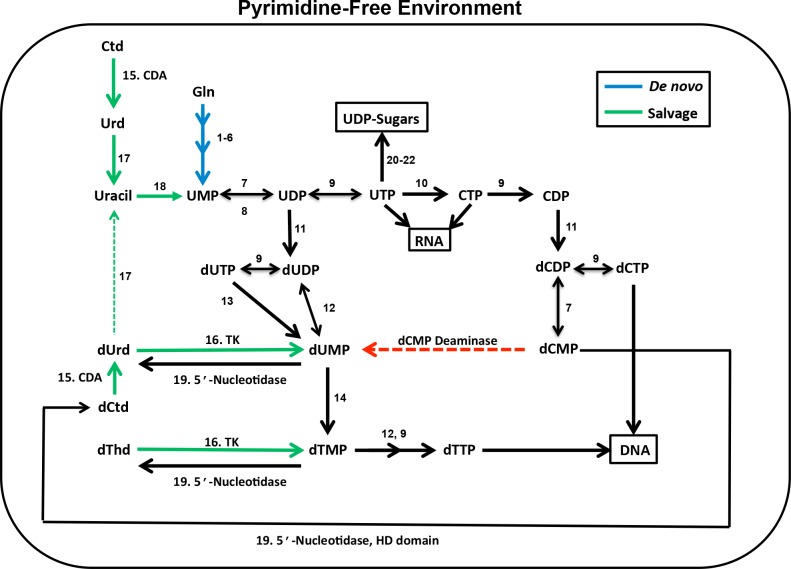

T. brucei pyrimidine pathway.Green lines salvage routes, blue lines de novo pathway, black lines interconversion routes, and the red dotted line indicates a reaction that is not present in trypanosomatids. The numbers above each arrow represent the enzyme catalyzing the reaction (EC number): 1–6: carbamoyl phosphate synthase (6.3.5.5), aspartate carbamoyl transferase (2.1.3.2), dihydroorotase (3.5.2.3), dihydroorotate dehydrogenase (1.3.98.1), orotate phosphoribosyltransferase (2.4.2.10), orotidine 5-phosphate decarboxylase (4.1.1.23); 7 UMP-CMP kinase (2.7.4.14); 8: nucleoside diphosphatase (3.6.1.6); 9: nucleoside diphosphate kinase (2.7.4.6); 10: cytidine triphosphate synthase (6.3.4.2); 11: ribonucleoside diphosphate reductase (1.17.4.1); 12: thymidylate kinase (2.7.4.9); 13: deoxyuridine triphosphatase (dUTPase) (3.6.1.23); 14: dihydrofolate reductase-thymidylate synthase (2.1.1.45); 15:cytidine deaminase (CDA) (3.5.4.5); 16: thymidine kinase (TK)(2.7.1.21); 17: uridine phosphorylase (2.4.2.3); 18:uracil phosphoribosyltransferase (2.4.2.9); 19: HD-domain 5’-nucleotidase (3.1.3.89); 20: UDP-glucose pyrophosphorylase (2.7.7.9); 21: UTP N-acetyl-α-D-glucosamine-1-phosphate uridylyltransferase (2.7.7.23); 22: UDP-glucose 4-epimerase (5.1.3.2). The pathway was constructed based on the annotation described in [10] and modified to incorporate results from our studies. Additionally enzyme 7 was added based on the published report that one of seven encoded adenylate kinases (ADKG) was biochemically characterized and shown to be a UMP-CMP kinase [16].